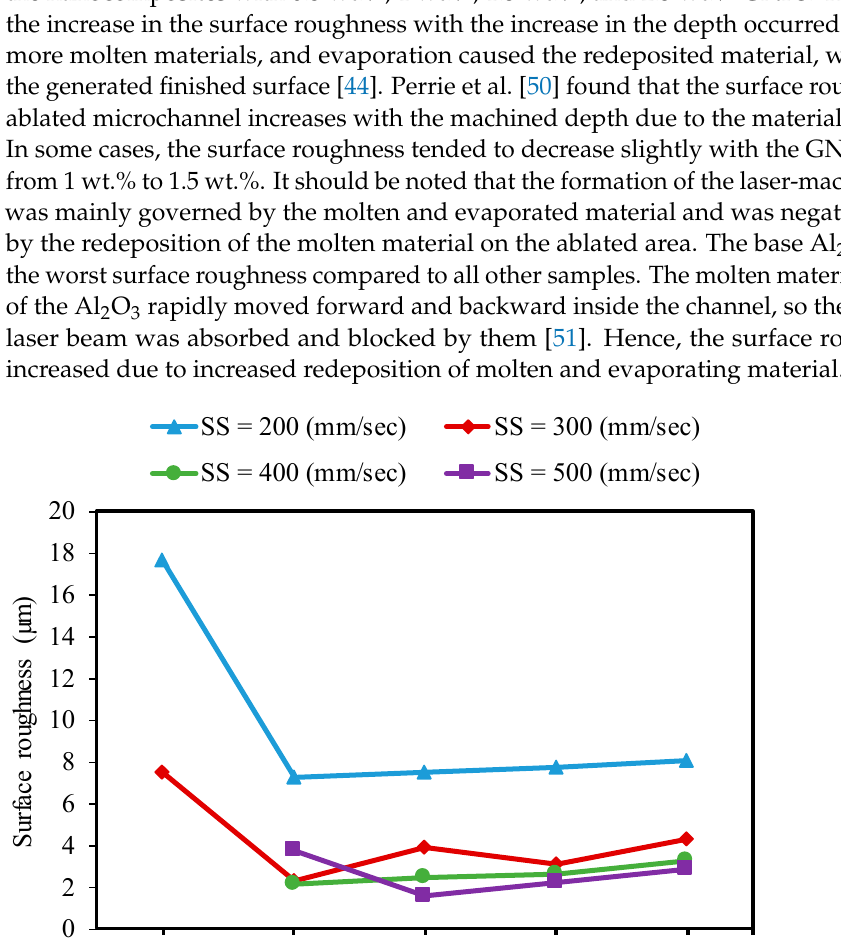
Figure 18. Percentage of improvement in surface roughness at a lower scanning speed of 200 mm/s.